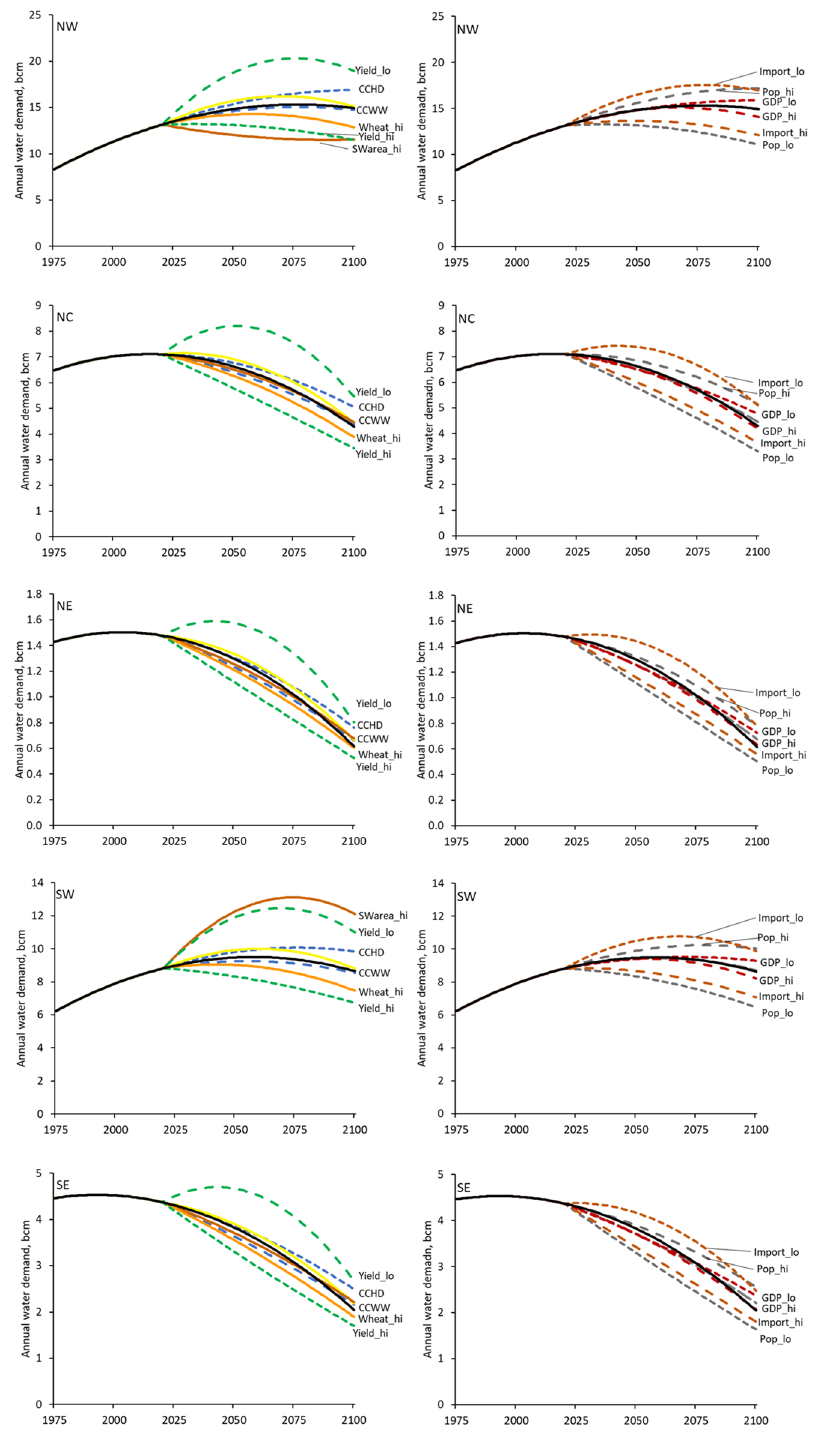
Figure 5. Volume of irrigation water demand in the scenarios for the five regions of Bangladesh. All curves are fitted polynomials, as shown in Fig. 4. The thick black line shows the base case in each plot. Note that the scale varies from region to